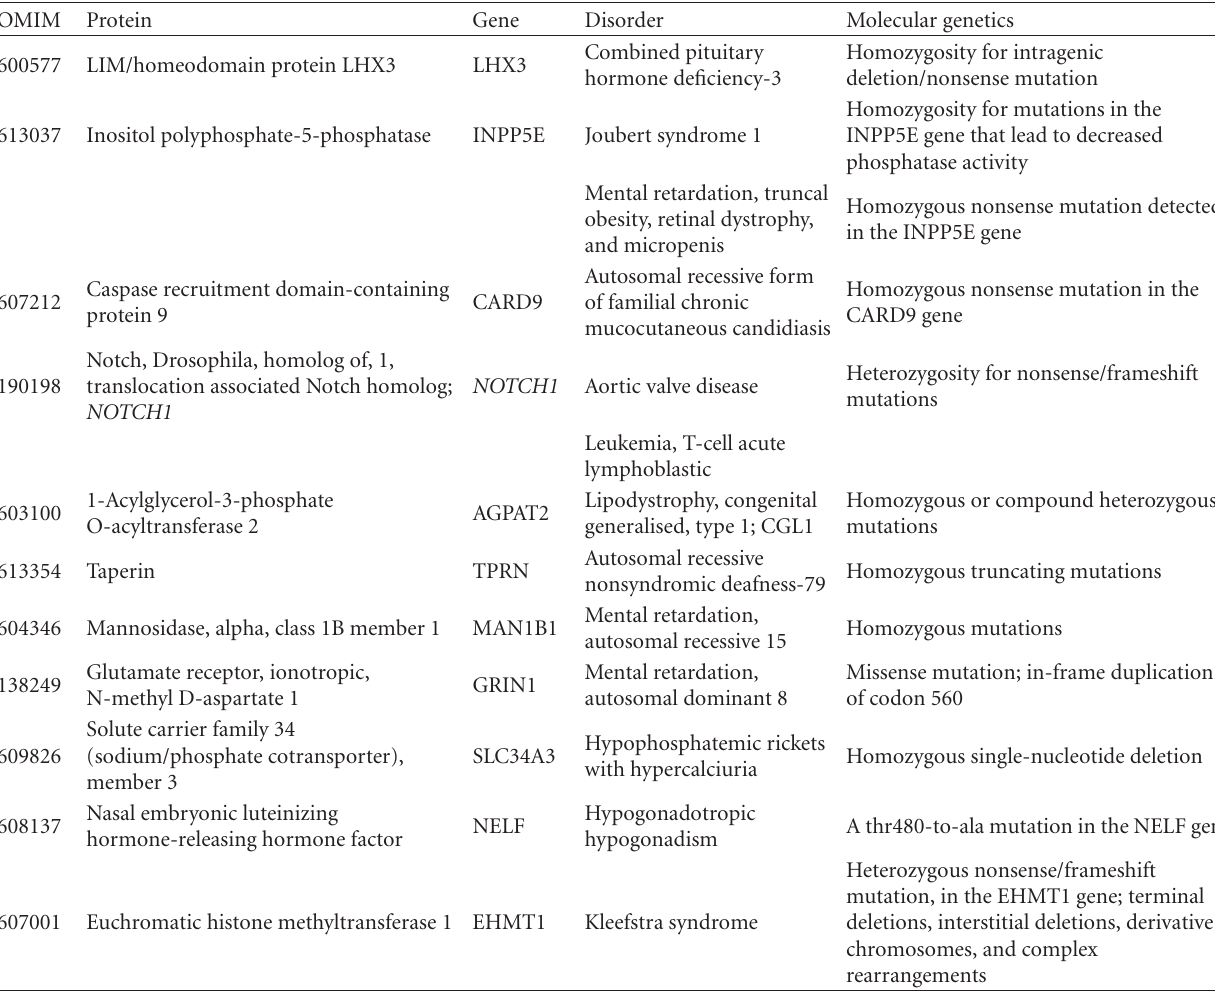
Table 2: Duplicated region and OMIM